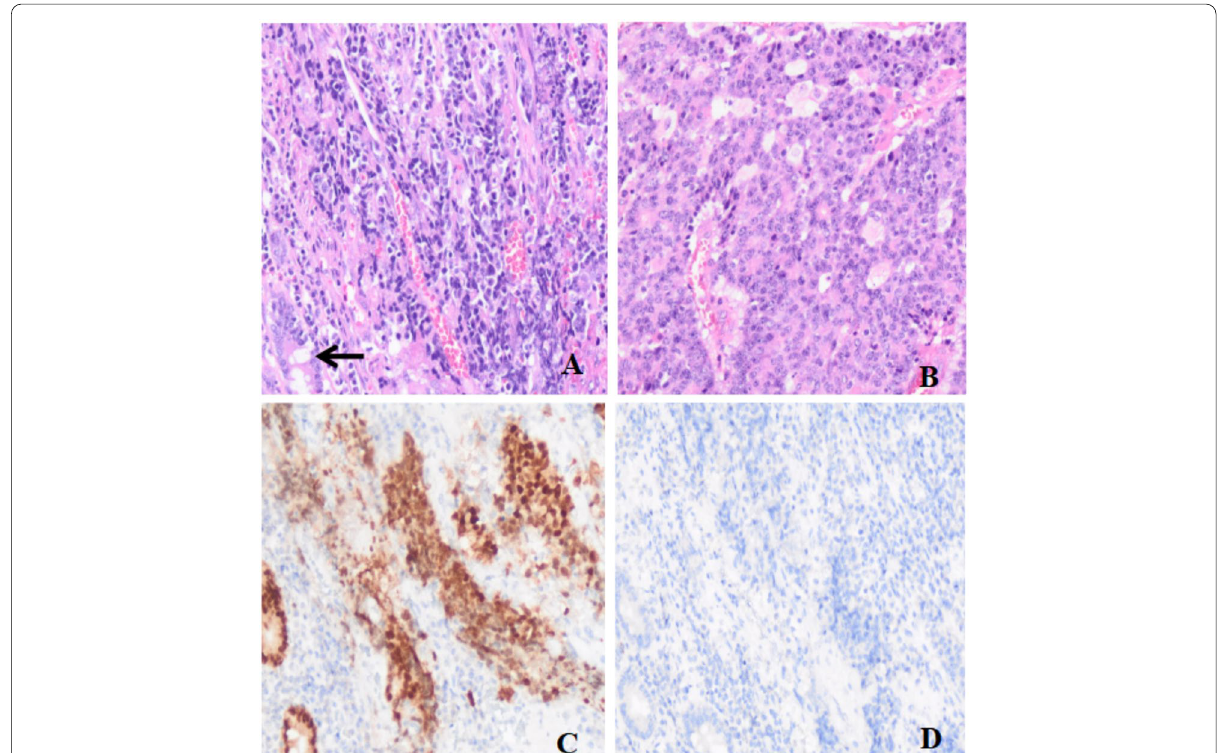
Fig. 2 H&E and immunohistochemical (IHC) staining of the adenocarcinoma in the rectum (magnification ✕ 200). A Normal rectum mucosa epithelium (black arrow head). B Cribriform and fused glands. C Strong positive expression of CDX-2 in cancer and mucosal epithelial cells. D Negative for NKX3.1 in cancer and mucosal epithelial cells